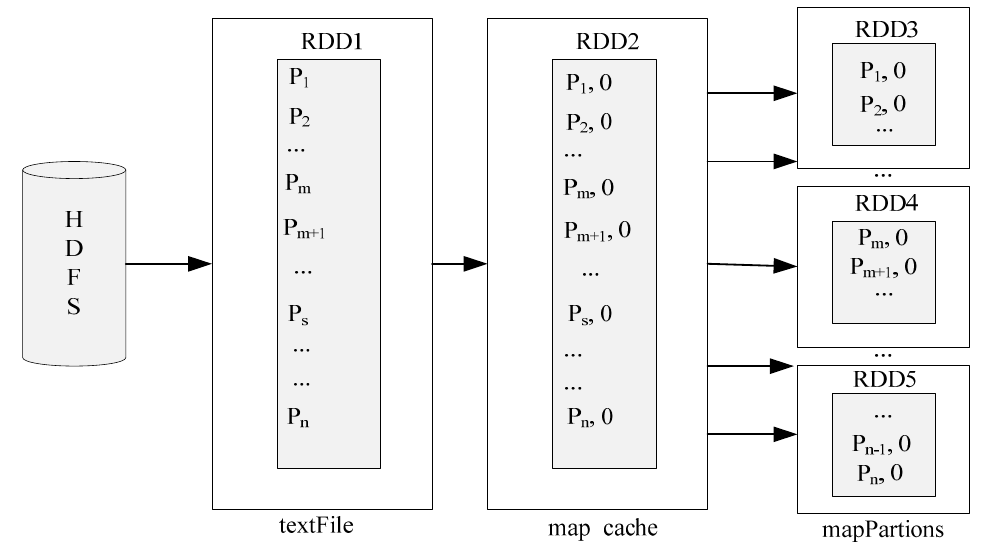
Figure 8. RDD conversion flowchart of the data partitioning stage.